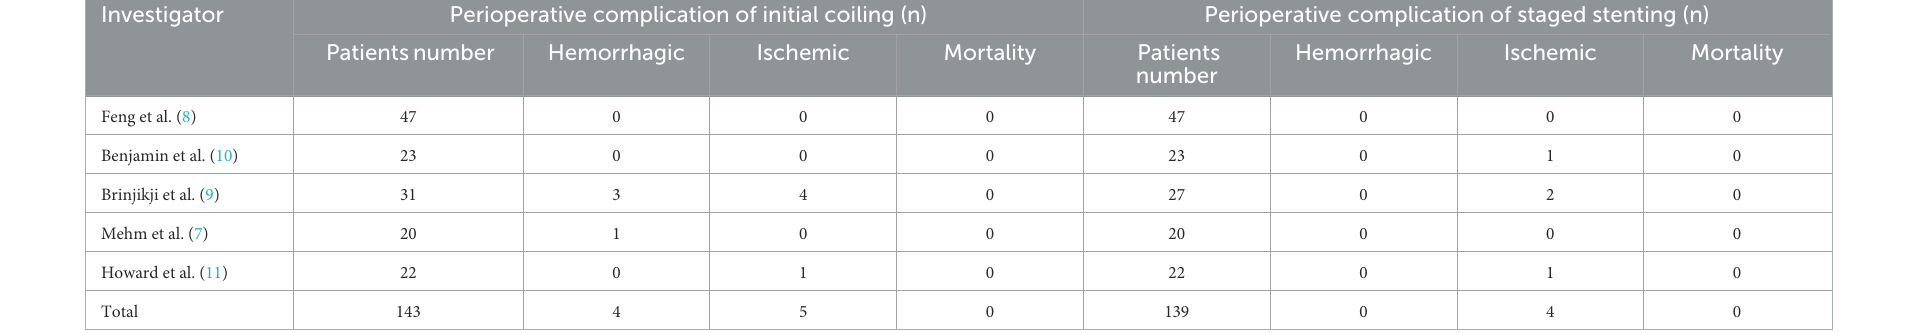
TABLE 3 Perioperative procedure-related complications and mortality in both stages.